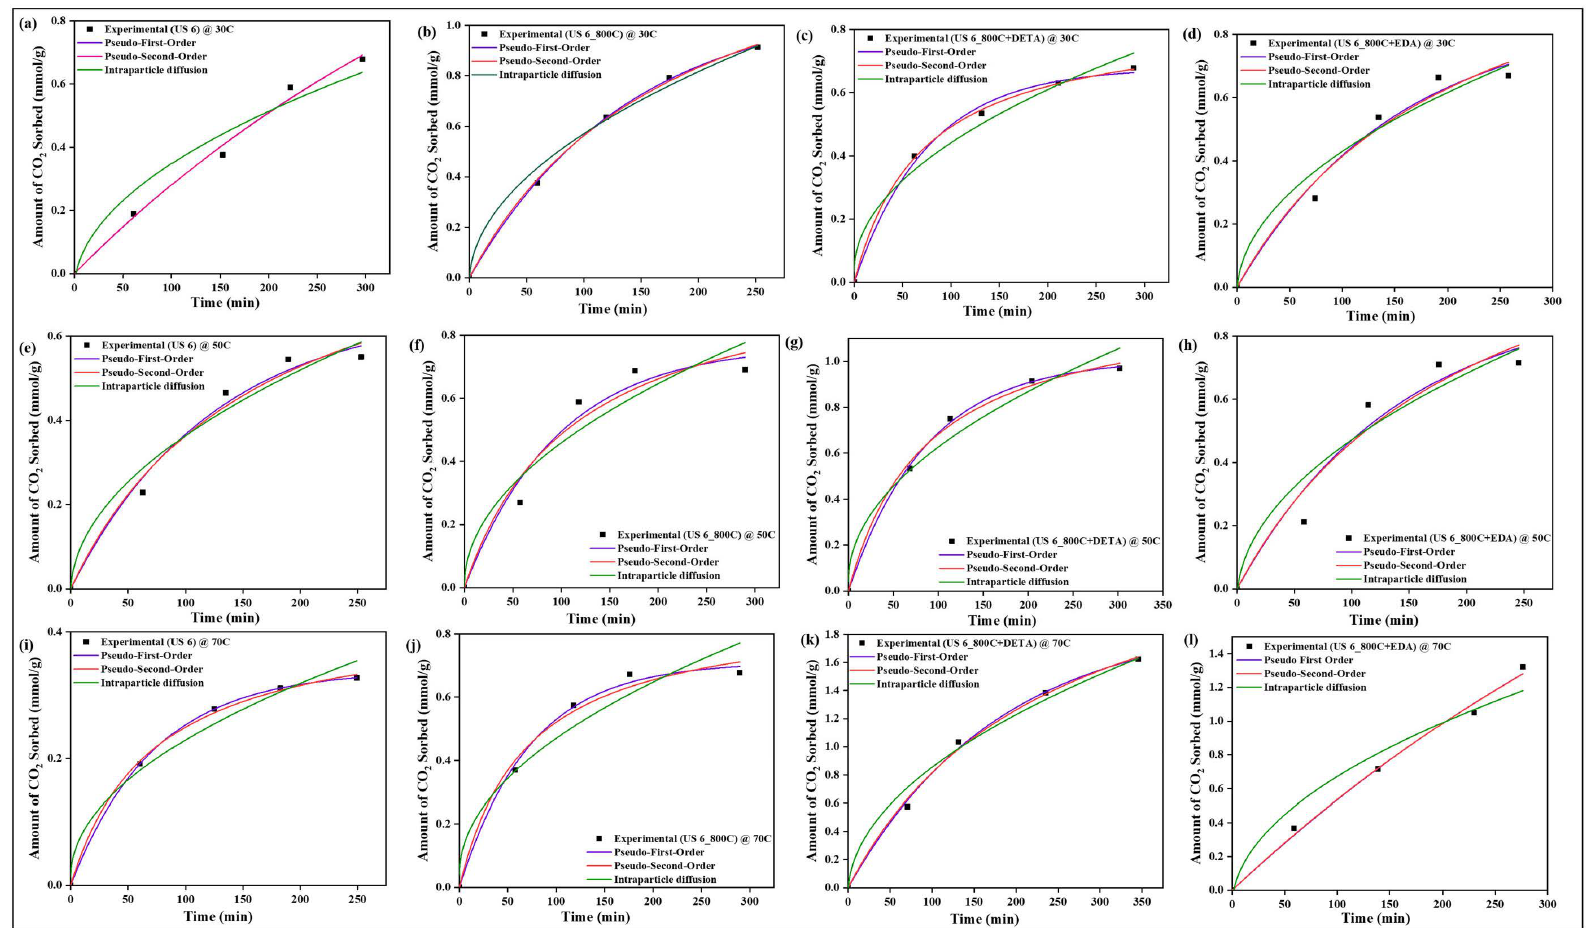
Figure 17. The prediction of sorption rate mechanism on US 6 variants at 30 ◦ C ( a – d ), 50 ◦ C ( e – h ), 70 ◦ C ( i – l ), and up to 8 MPa